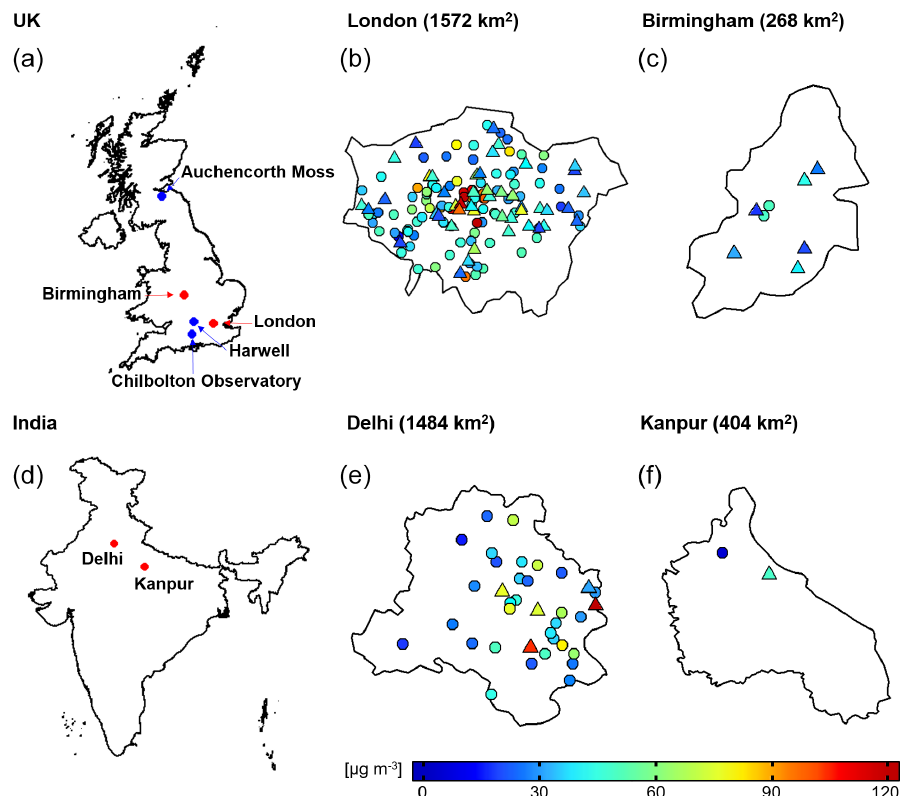
Figure 1. Spatial extent of surface NO 2 monitoring stations in London (b) , Birmingham (c) , Delhi (e) , and Kanpur (f) . Panels (a) and (d) show the location of the target cities (red) and UK sites that are part of the European Monitoring and Evaluation Programme (EMEP) (blue). Panels (b) , (c) , (e) , and (f) show the locations of local authority regulatory NO 2 monitoring stations within the administrative boundaries of each city, coloured by mean midday NO 2 for 2005–2018 and separated into sites used (triangles) and not used (circles) to assess satellite observations of NO 2 (see text for details). The surface area of each city is indicated. Country and city boundaries are from GADM version 3.6 (GADM, 2018) and DataMeet (DataMeet,